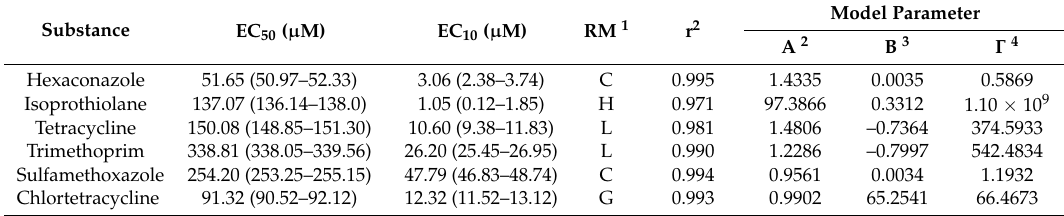
Table 2. Parameters of the regression models for dose-response curves of A. fischeri for pesticide and pharmaceutical single compounds in Table S1 (the 95% confidence intervals are provided in the